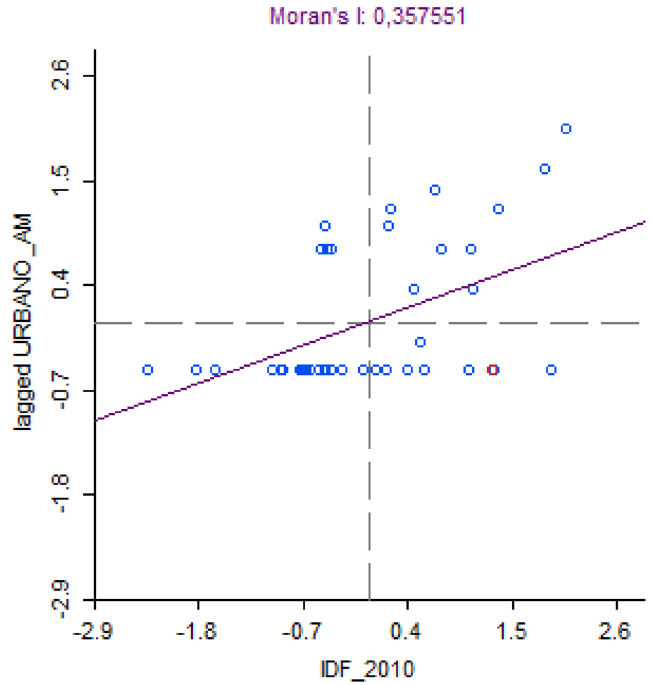
Fig. 2 Global Moran Index for the fiscal efficiency (IDF_2010) and the categorization of the area (by metropolitan area). Source: own computation based upon GeoDa